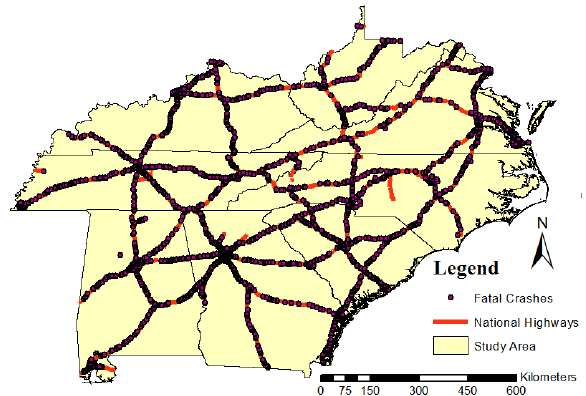
Figure 2. Fatal crashes on US rural highways